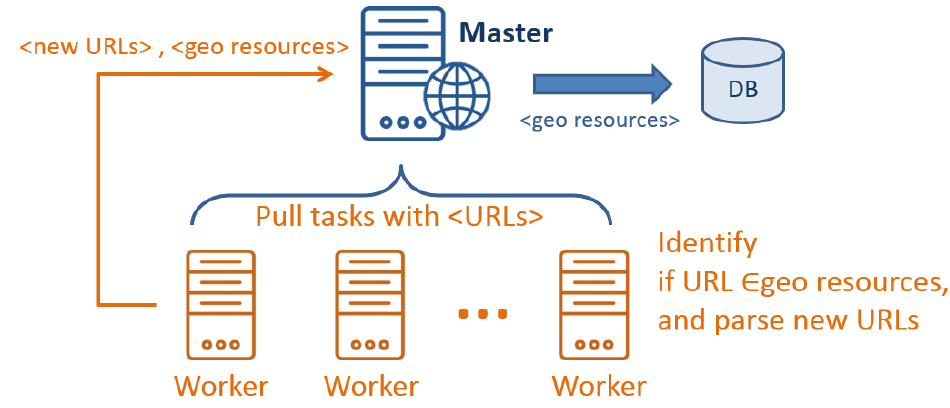
Figure 5. Architecture of distributed computing implementation.